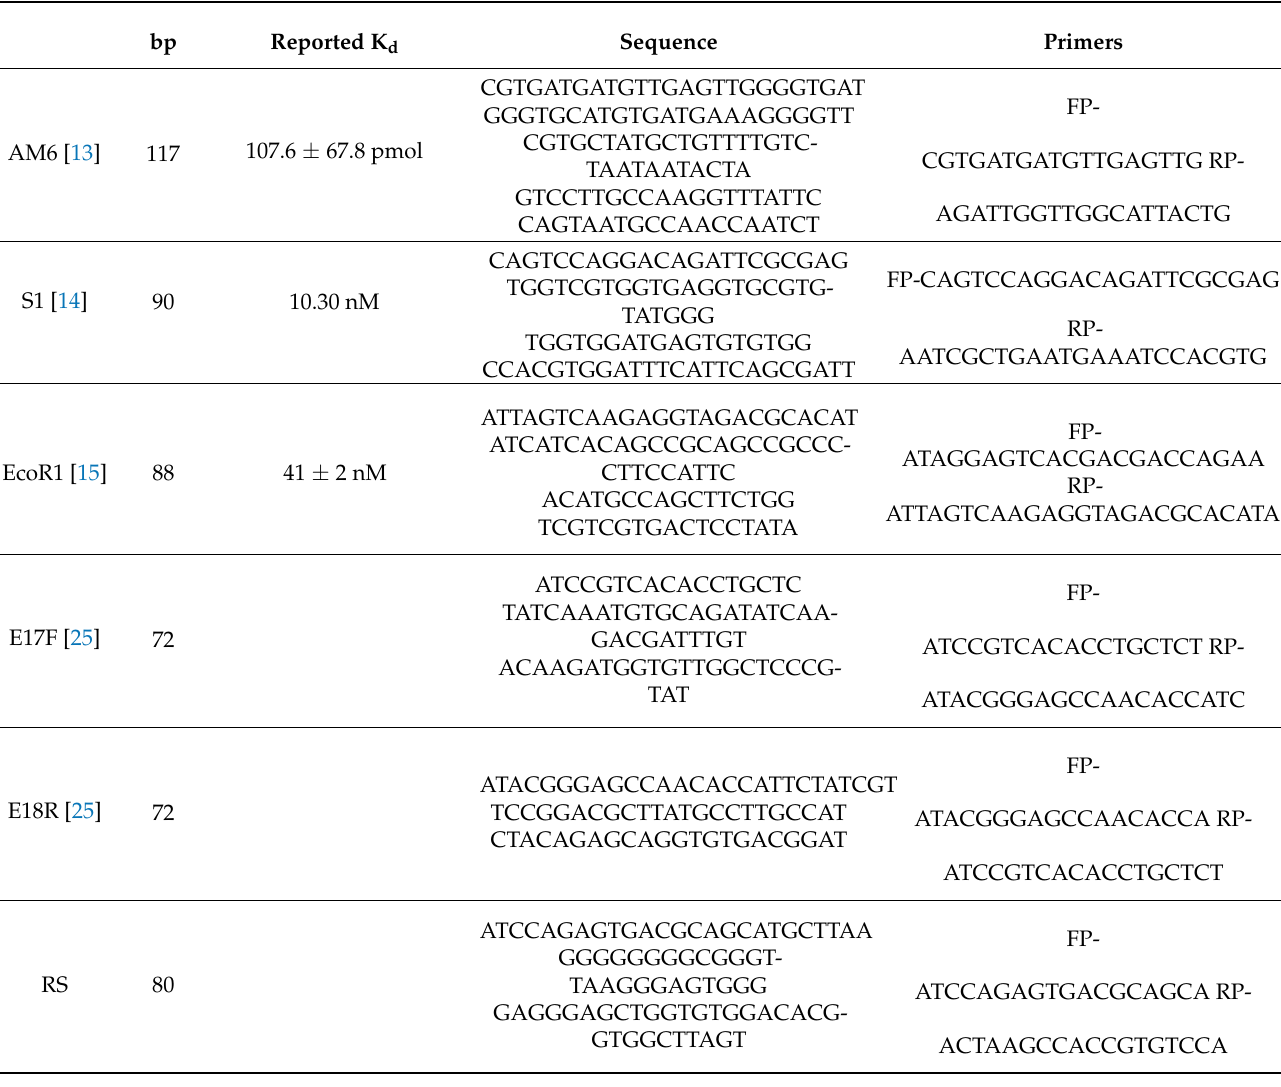
Table 1. Aptamers analyzed in this study with its